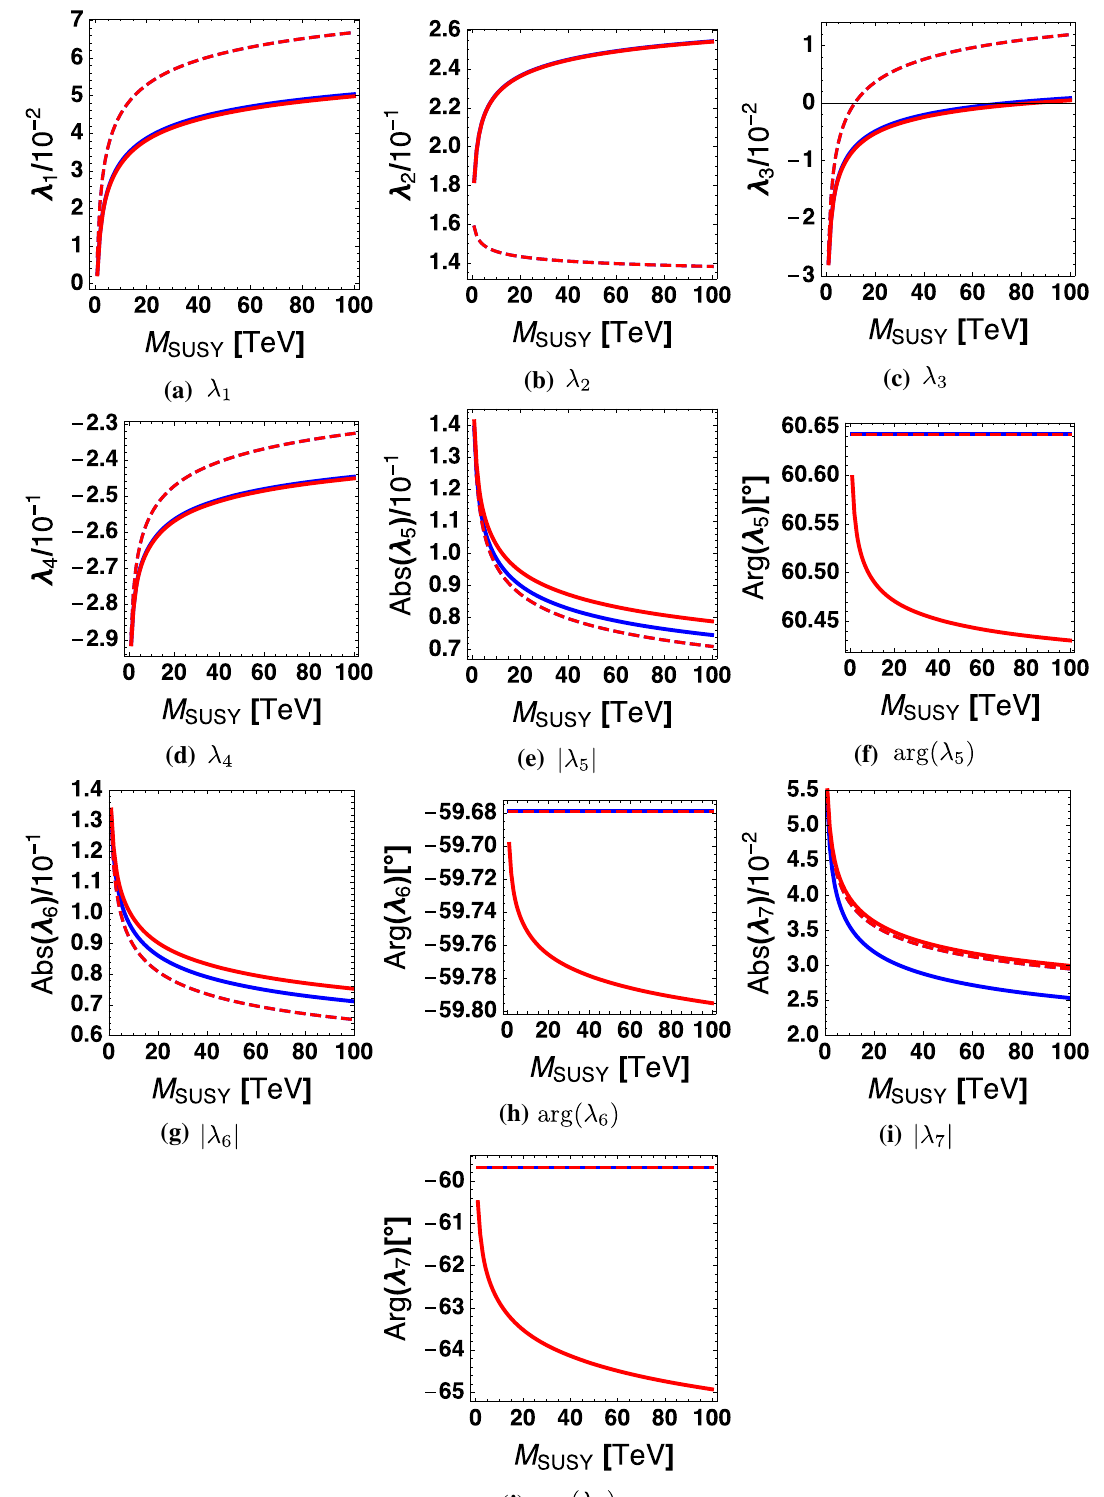
Fig. 3 The quartic couplings’ dependence on M s for the default sce- nario: tan β = 5, ϕ A = 2 . 1 ≈ 120 ◦ , ϕ μ = ϕ M M H + = 500 GeV. The red curves are the result of employing complex